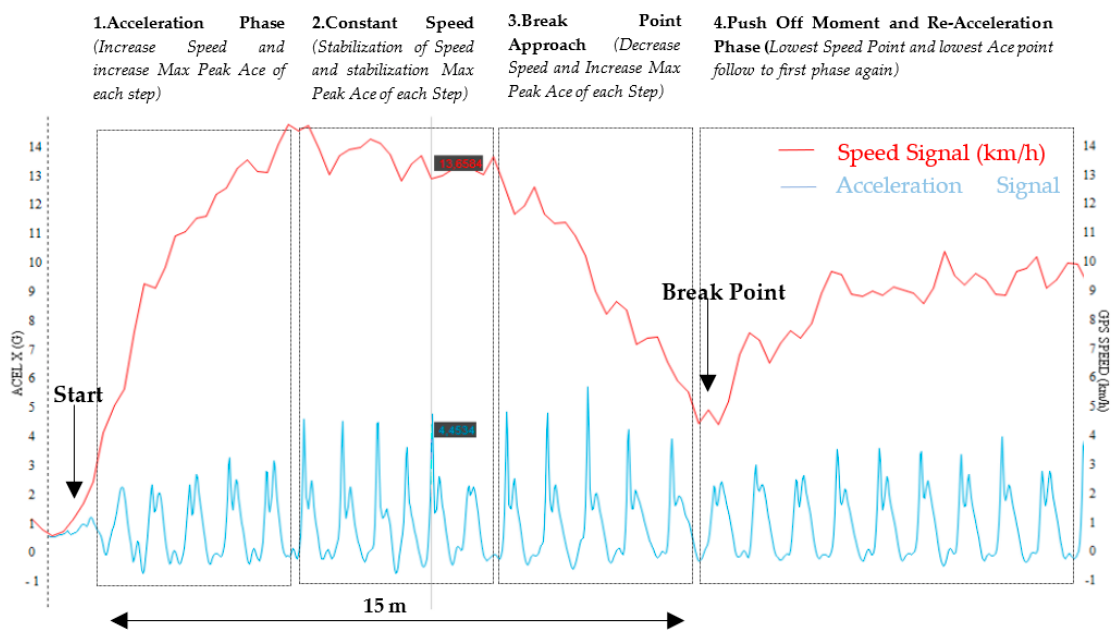
Figure 3. Circuit for testing.